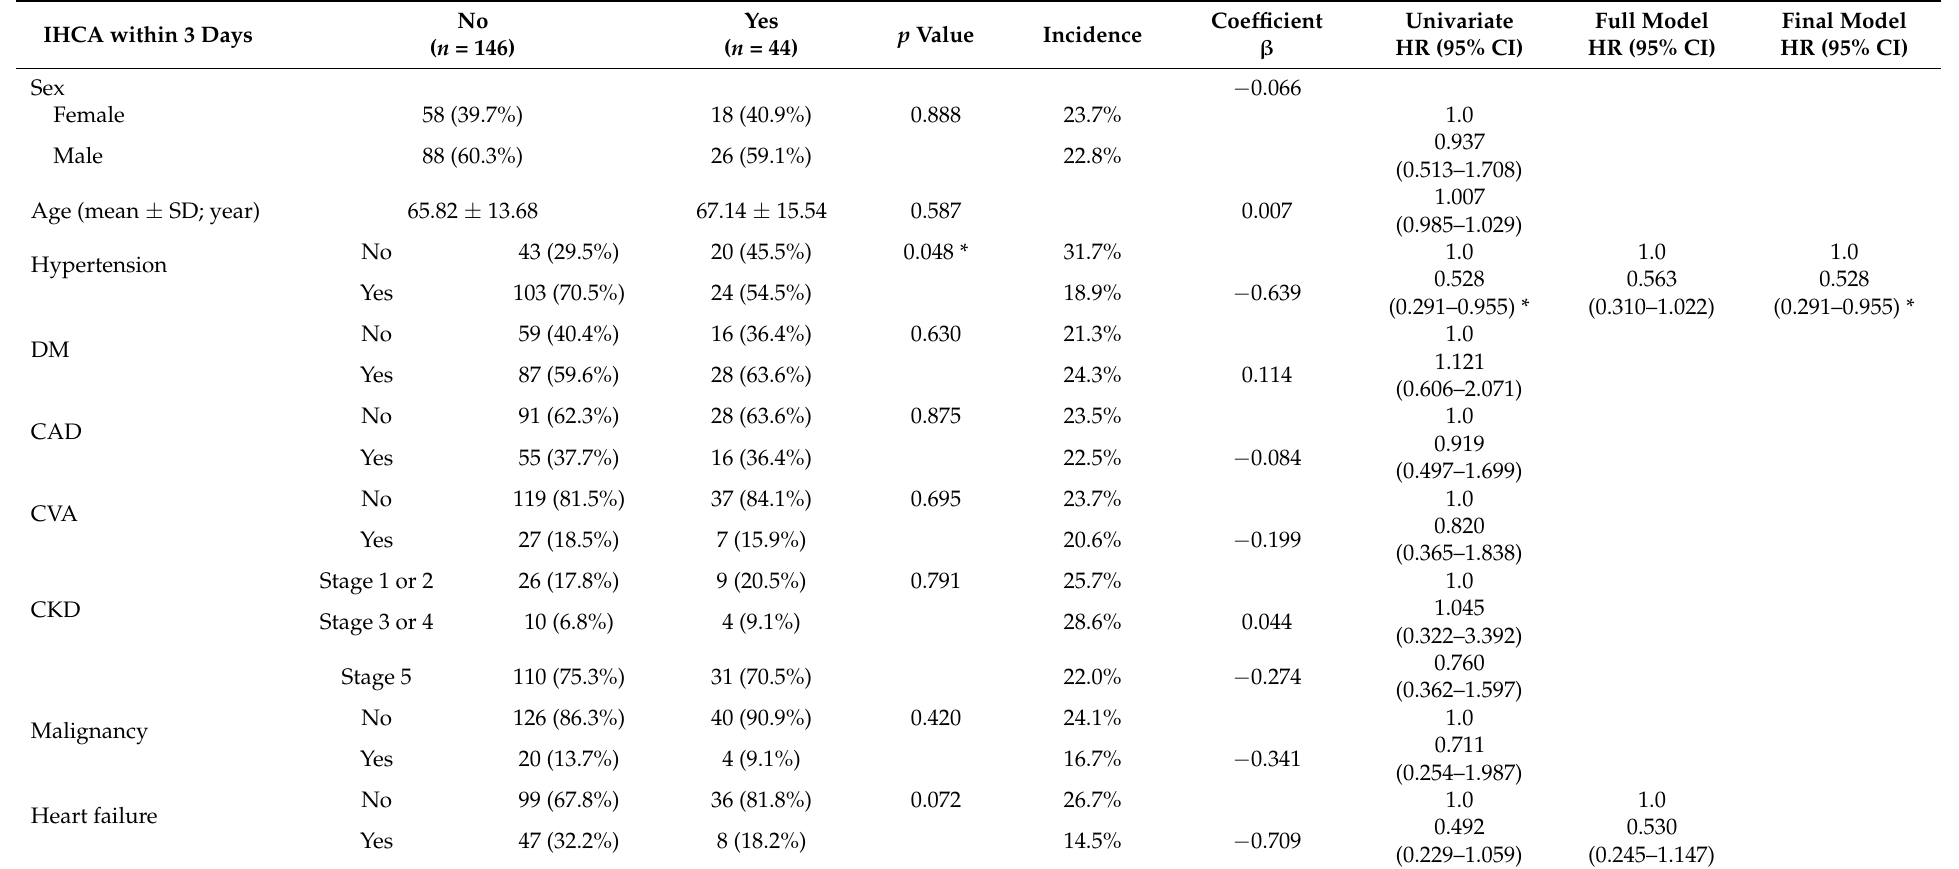
Table 1. The characteristics of the study subjects and underlying comorbidity domain for the incidence of in-hospital cardiac arrest (IHCA) with COX